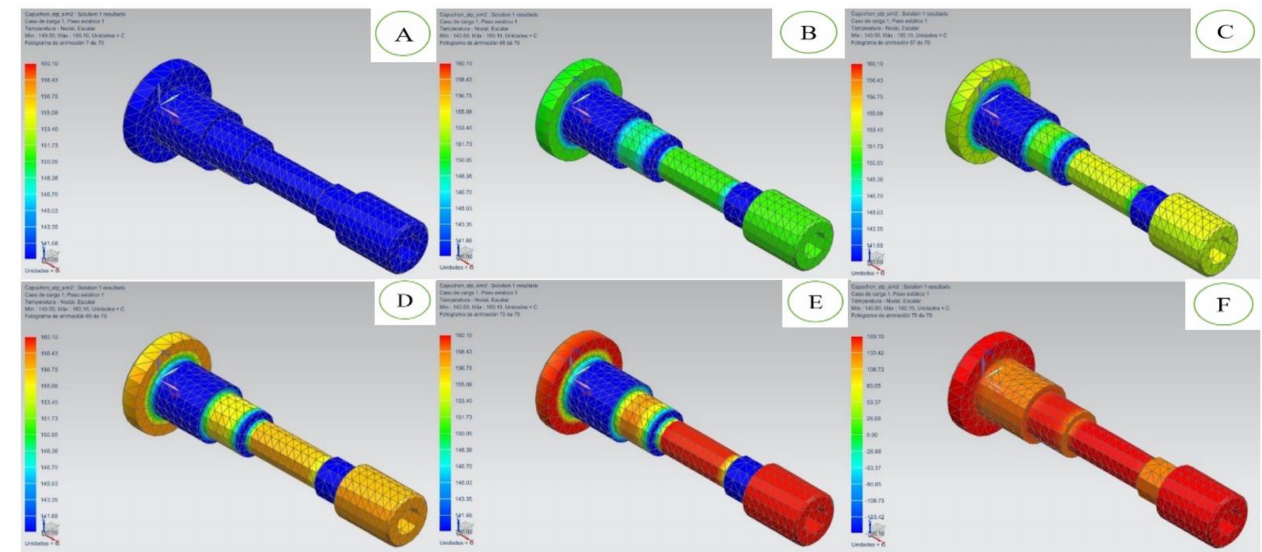
Figure 8. Thermal sequence of PVC from ( A – F ) related to the time of simulation.